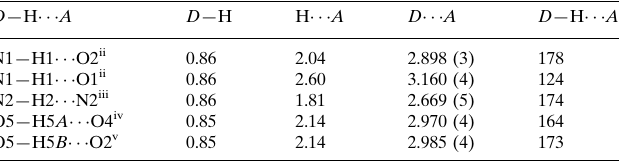
Hydrogen-bond geometry (A˚ , (cid:3) ).